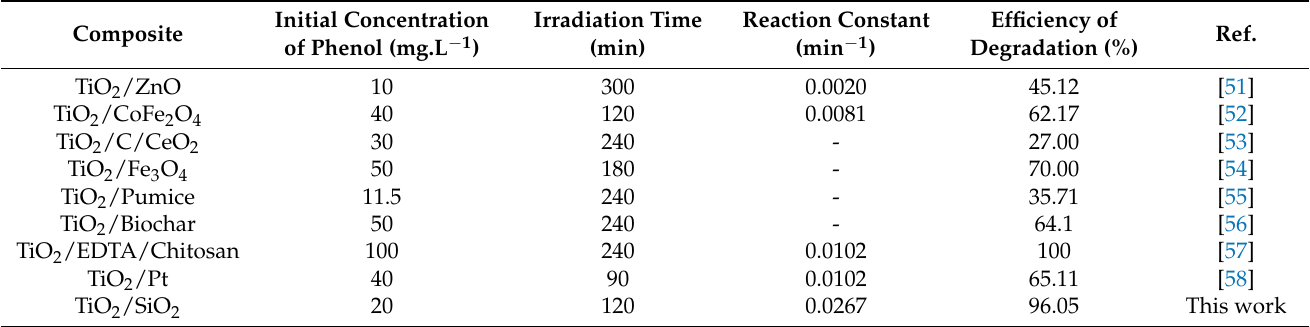
Table 11. Comparison of the photocatalytic activity of this work with several previous reports of various TiO 2 composites in phenol